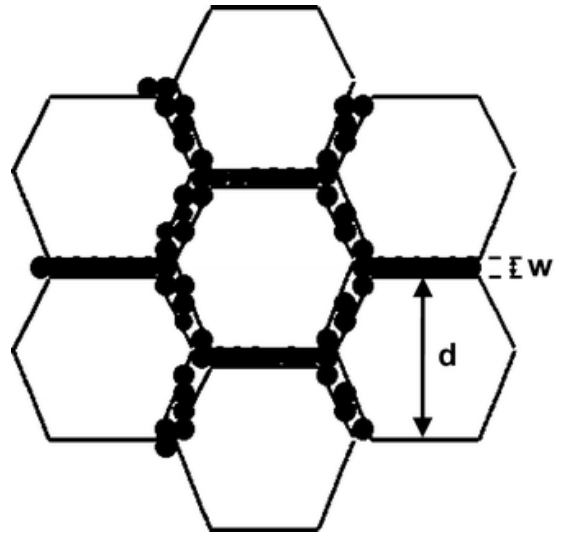
grain boundaries but are also within the grains